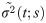
Relation between the variance and the average of the trading volume in 1S08.For both panels the ultramarine blue dots represent the morning values and the navy blue triangles the afternoon ones. Left Panel: Variance v mean trading volume averaged over all the companies for s = 9. The values of σ2˜(t;s) and μ˜(t;s) are scaled by 108 and 104, respectively. The orange and the pink lines represent the parabolic fit for curves of the morning and the afternoon periods yielding the following parameters: 2.01 ± 0.06 and 1.43 ± 0.04, respectively. Right panel: Value of the parabolic coefficient of the morning and the afternoon parts of the trading session as a function of the semester.